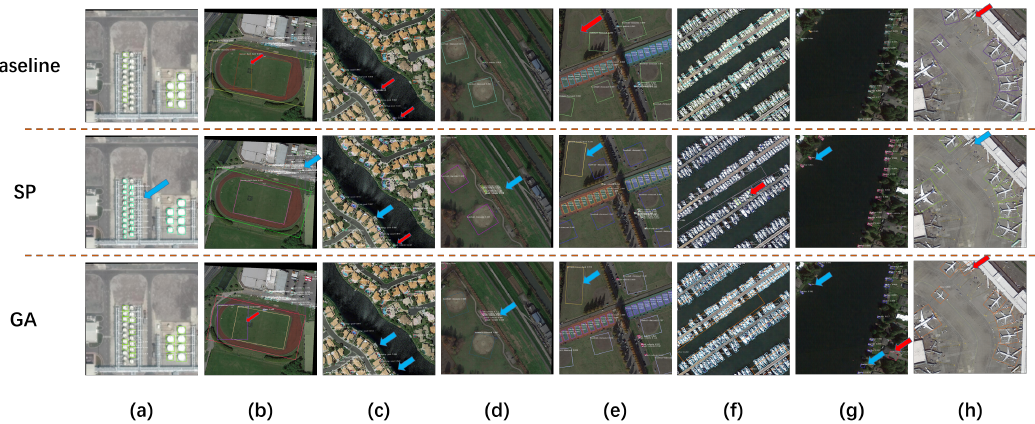
Figure 14. Visualization of the baseline, the SP and the GA results in the DOTA test dataset. The first line is the results of the baseline, which is the Faster RCNN detector with the FPN and the convolutional head. SP (the second line) means a network with only the saliency pyramid based on the baseline. GA (the third line) means a network with only the global attention network based on the baseline. In addition, ( a – h ) are eight different scenarios. The red arrow indicates the false detection or missed detection apparently in the three images in a column, while the blue arrow indicates the better detection area in the three images in a